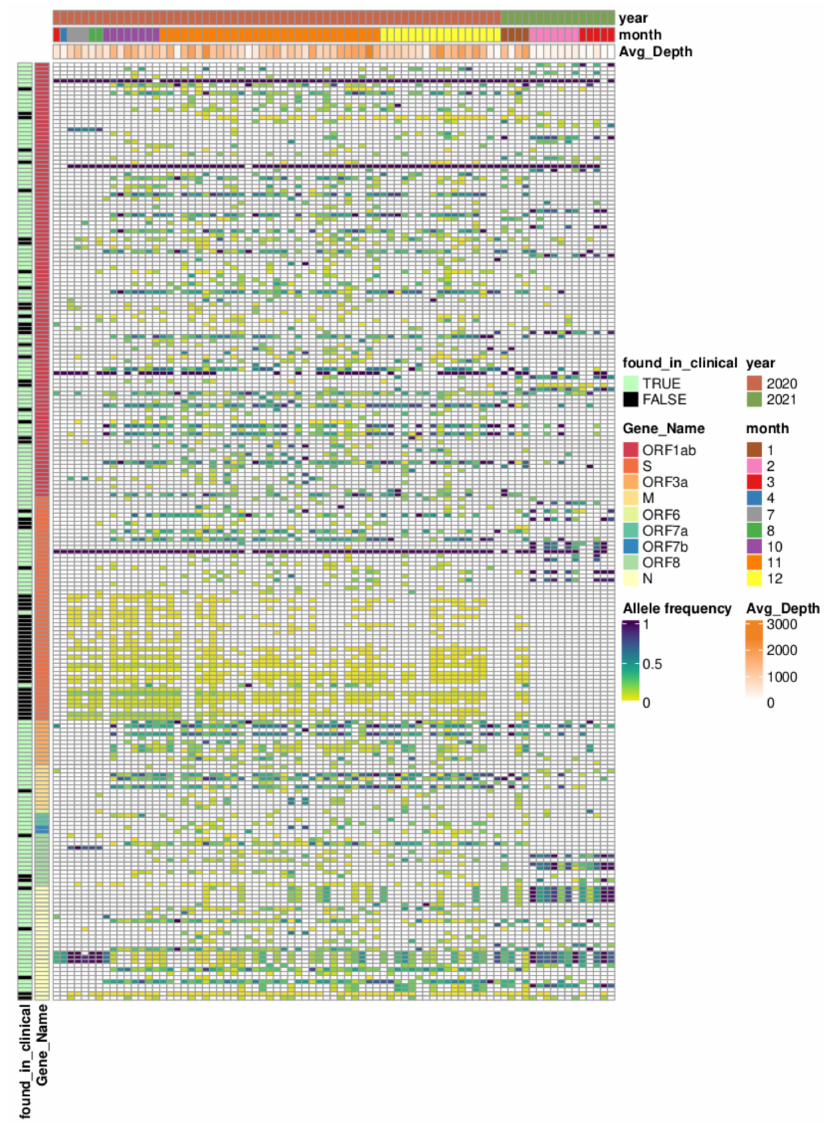
Figure 1. Nucleotide mutations detected in more than five wastewater samples with respective allele frequencies. Columns are ordered according to sampling date, and rows are ordered according to genomic position. Column annotations provide sample specific information such as the date of sampling, average sequencing depth per sample, and sampling location. Row annotations highlight the respective genes and whether a mutation has been detected in any clinical